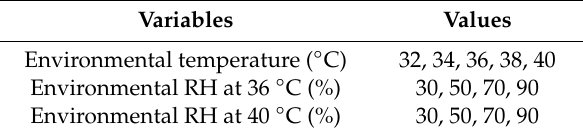
Table 1. Environmental temperatures and RHs considered in the parametric